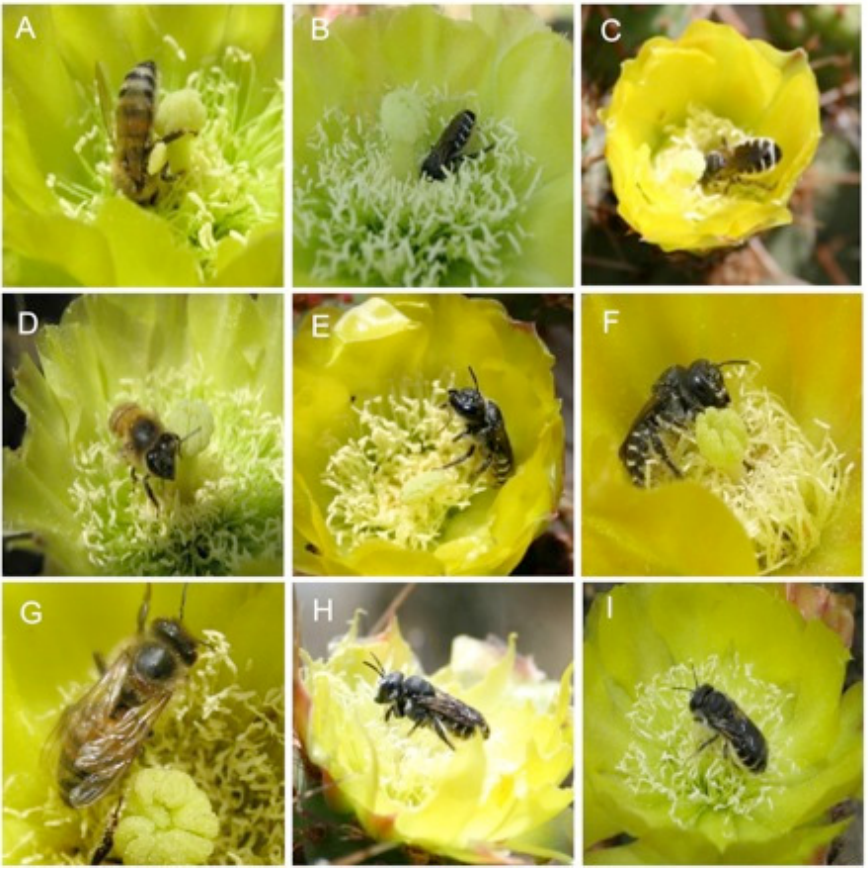
Figure 2. Body position of feeding in Apis mellifera bee ( A ), and male ( B ) and female ( C ) of Lithurgus littoralis. Alert position in A. mellifera ( D ), and male ( E ) and female ( F ) of L. littoralis. Horizontal position in A. mellifera ( G ), and male ( H ) and female ( I ) of L. littoralis bees observed while visiting flowers of Opuntia huajuapensis